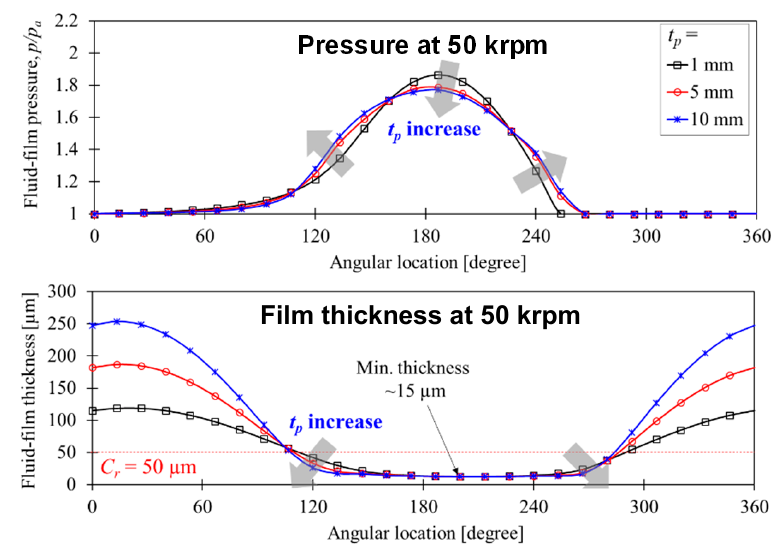
Figure 8. Predicted fluid-film pressure and thickness distributions at a rotor speed of 50 krpm depending on the polymer layer thickness.